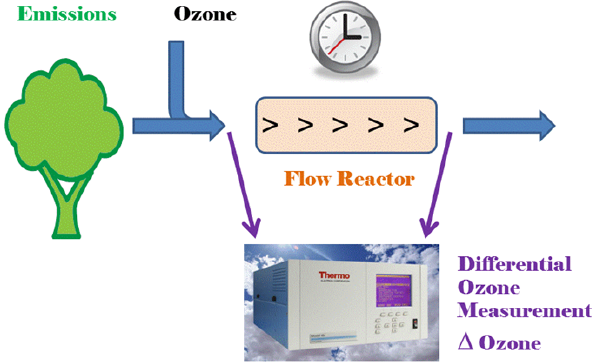
Figure 1. Principle of the ozone reactivity measurement of biogenic emissions with one monitor that is configured for differential ozone signal